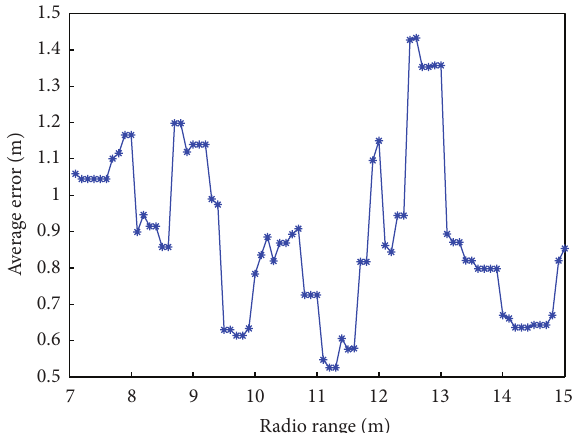
Figure 6: The average estimated error with different sensing radii for path 1 movement.